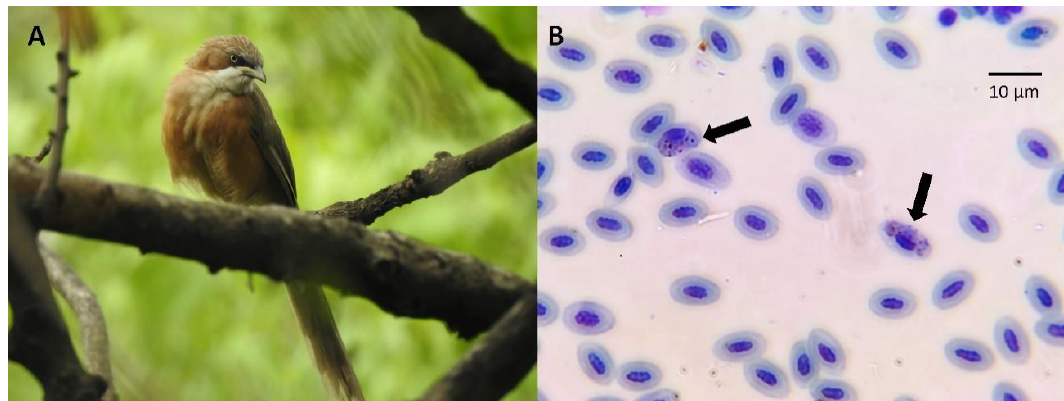
Figure 4. ( A ) White-throated babbler ( A. gularis ) photographed in Mandalay hill, and ( B ) two macrogametocytes of lineage H_TURSTR02 (arrows), observed in a white-throated babbler’s Giemsa-stained blood smear using oil immersion objective lens (scale bar 10 µm). Picture credits: Jaime Muriel ( A ) and Sergio Magallanes ( B ).